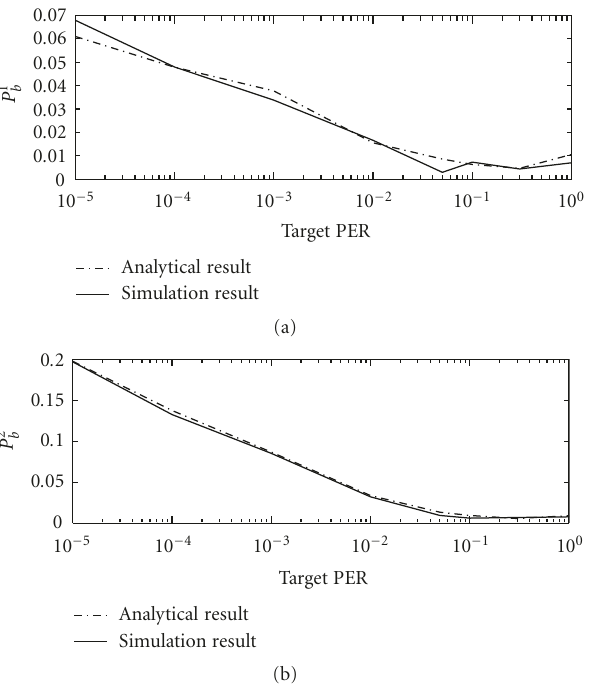
Figure 3: SMDP-based AC policy: analytical and simulated block- ing probabilities as a function of ρ = 10 − 4 . ρ 1